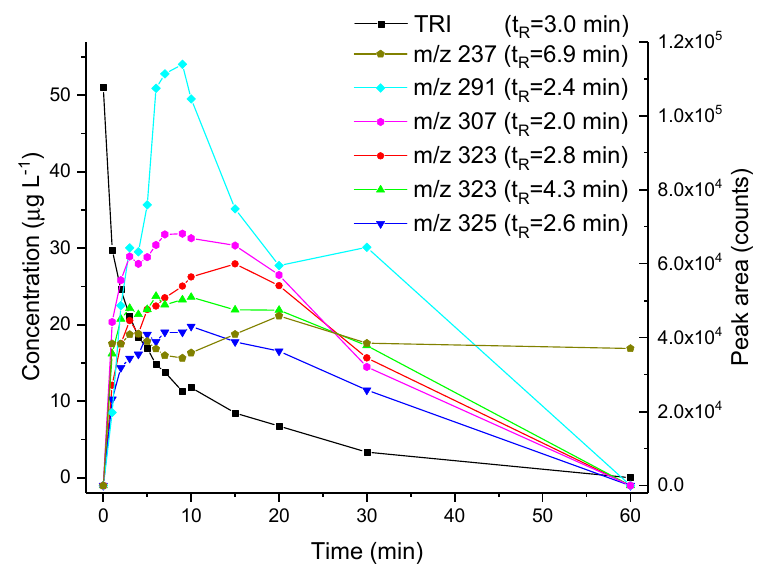
Figure 4. Profile of degradation of TRI and formation of its transformation products with the electro-assisted Fenton reaction setup. Only the concentration of TRI was measured (left axis). For the oxidation products, peak areas were used to measure their relative abundance as a function of time (right axis).